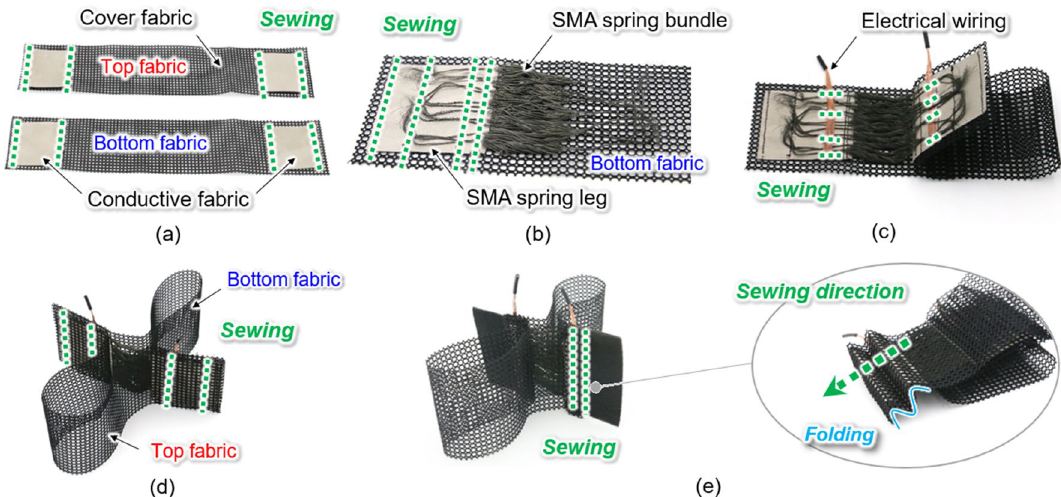
Figure 3. Fabric muscle fabrication process. ( a ) To electrically connect the SMA springs, the conductive fabric (50 mm × 50 mm) is sewn (green dotted lines) and fixed to the cover fabric (both top and bottom fabrics, width 60 mm, height 300 mm). ( b ) 200 SMA springs are aligned on the cover fabric (bottom fabric). SMA spring legs are arranged above and below the conductive fabric and sewn fixed so that electricity can flow to the SMA springs. ( c ) Electrical wires are arranged above and below the conductive fabric and sewn fixed to supply external power to the SMA springs. ( d ) Cover fabrics (both top and bottom) are overlapped so that the conductive fabrics align and then sewn. ( e ) Conductive fabric part with the SMA spring legs fixed is folded twice and fixed with